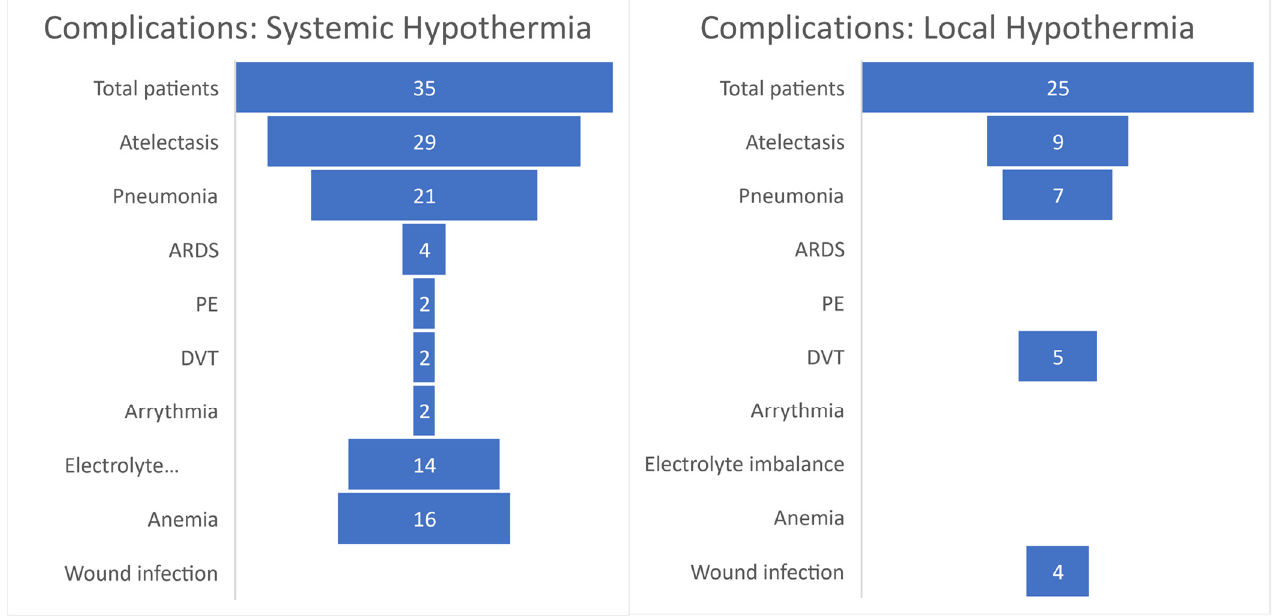
Figure 3. TSCI complication rates in patients treated with hypothermia. ARDS = acute respiratory distress syndrome; PE = pulmonary embolism; DVT = deep vein thrombosis.